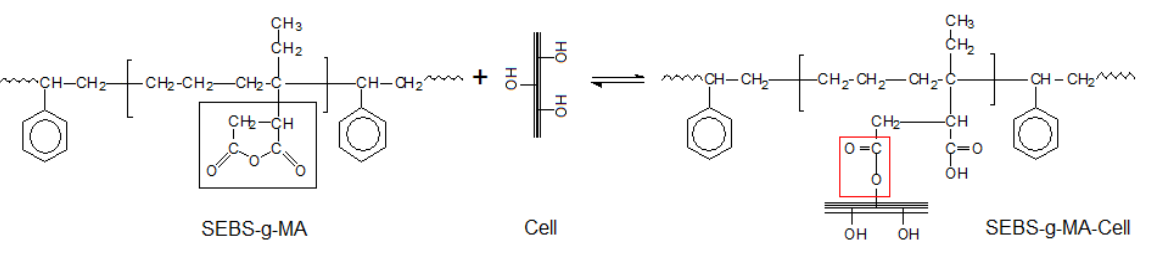
Figure 9. SEM micrographs of (a) SEBS-g-MA/Cell 50/50, (b) PS-co-MA/Cell 50/50, (c) PS/Oat/PEG composites and (d) PS/CaCO